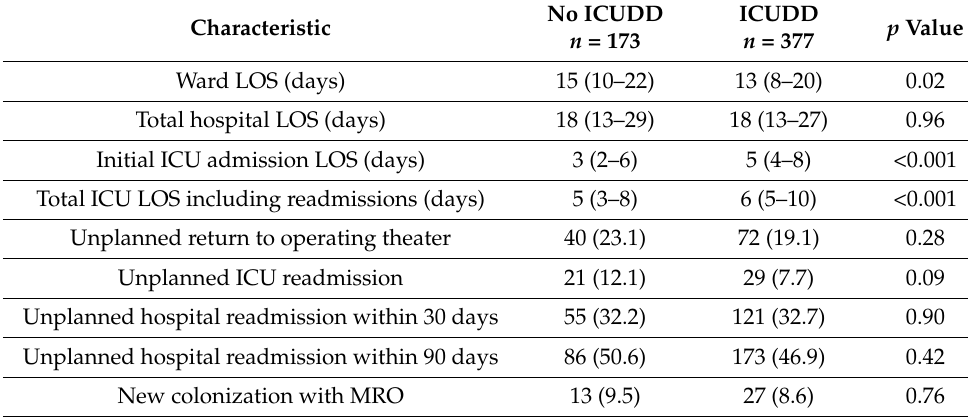
Table 2. Comparison of outcomes between patients with and without